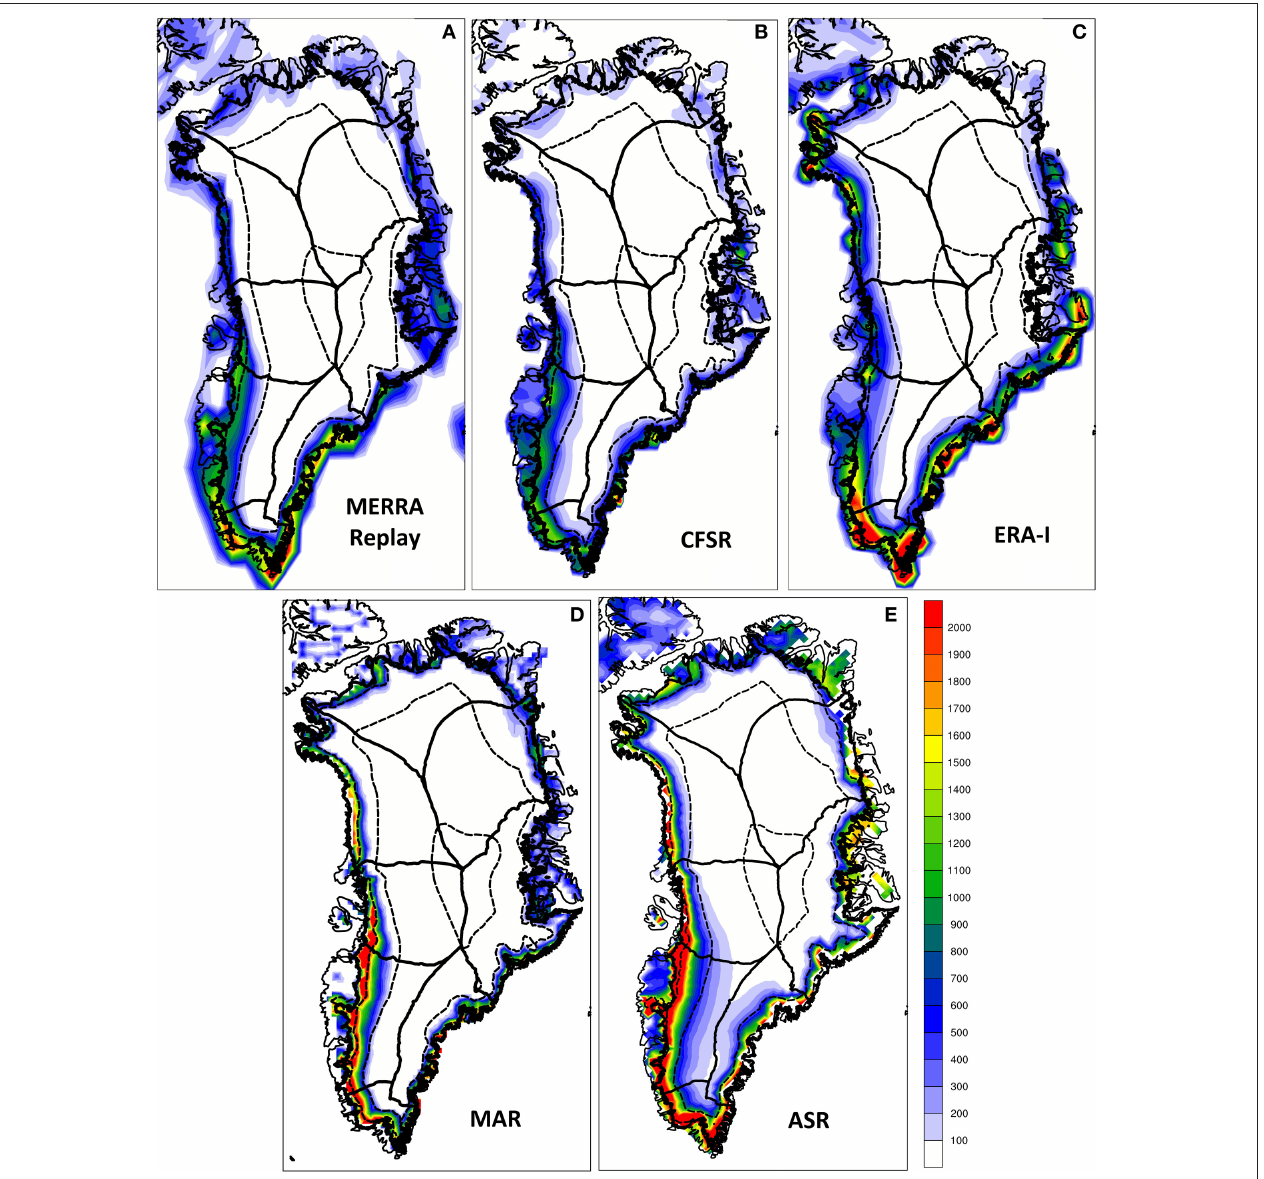
FIGURE 8 | Average surface runoff per year for 2000-2012 for (A) MERRA-replay (B) CFSR, (C) ERA-I, (D) MAR, and (E) ASR, in mm w.e. yr − 1 . Boundaries of major GrIS drainage basins of Zwally et al. (2012) are indicated, and surface orography from Bamber et al. (2001) is indicated with dashed contours for every 1000m of